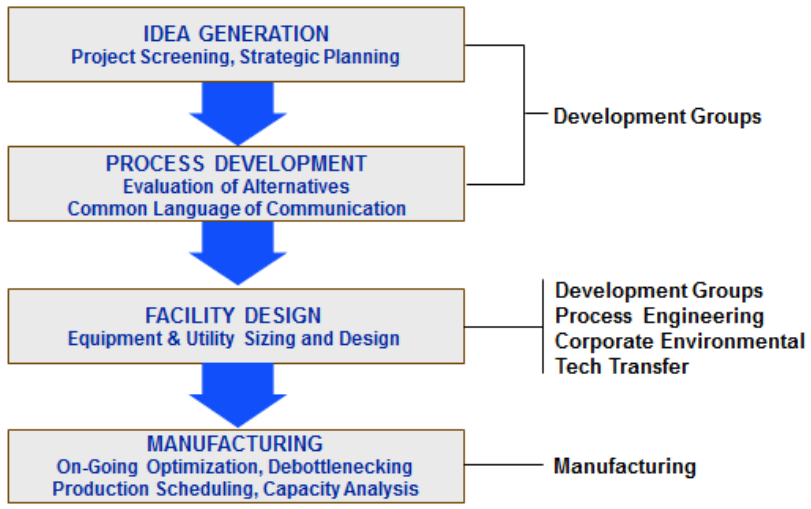
Figure 1. Benefits from the use of computer